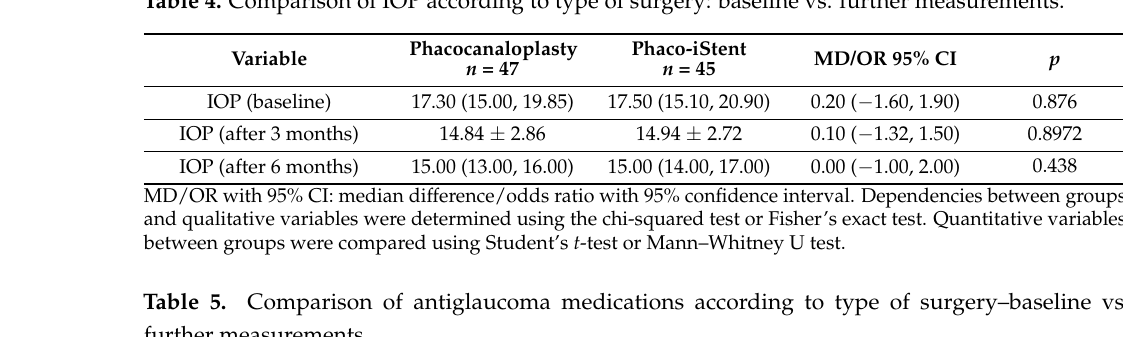
Table 4. Comparison of IOP according to type of surgery: baseline vs. further measurements.